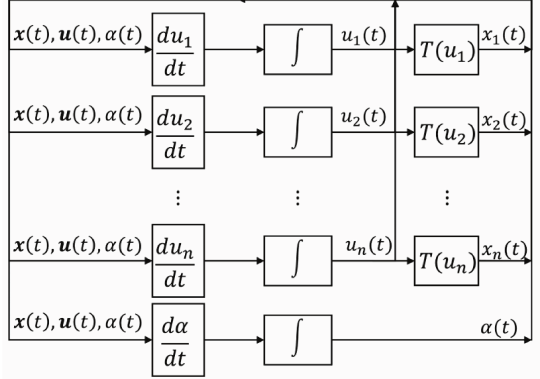
Figure 4. Analog realization of (21) in the block diagram